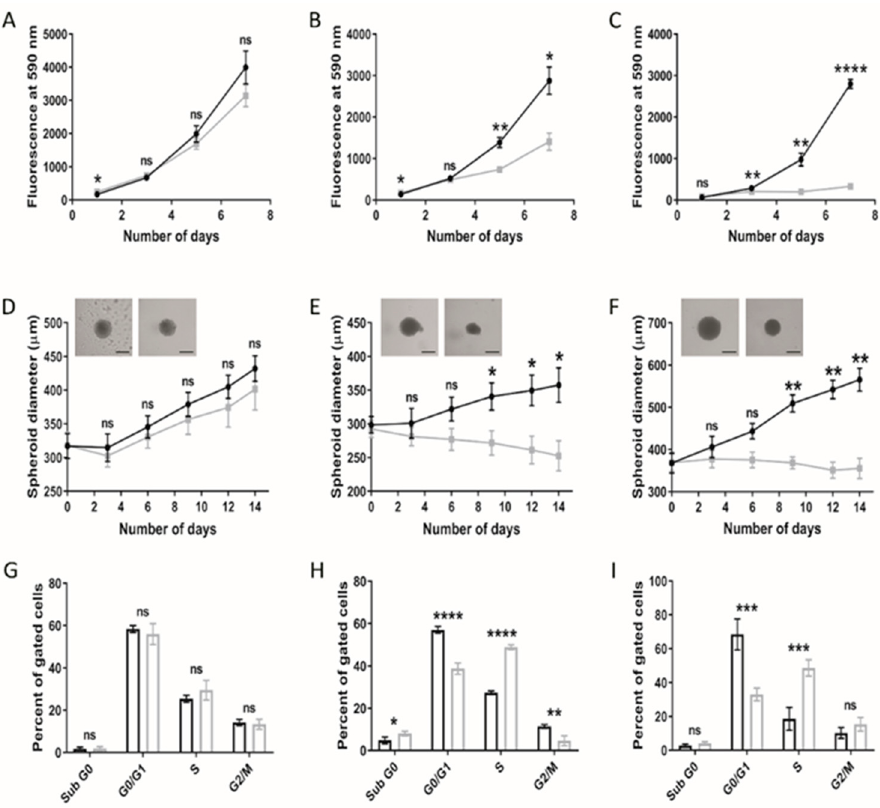
Figure 1. Altered growth characteristics of adult and paediatric diffuse glioma cells under lipoprotein-deplete conditions. U373 (adult GBM), KNS42 and SF188 (both paediatric diffuse glioma) cells were grown under lipoprotein -replete (black) or -deplete (grey) conditions in monolayer ( A – C ) or spheroid ( D – F ) format, respectively, over a 7- or 14-day period, respectively. ( D – F ) Brightfield images are representative of 14-day old spheroids in lipoprotein-replete (left) or -deplete (right) conditions. Black bars depict 300 µm in scaled length. ( G – I ) Flow cytometric cell cycle analysis following U373, KNS42 and SF188 monolayer culture, respectively, under lipoprotein -replete (black) or -deplete (grey) conditions for 72 h. Results are the mean ± SEM ( A – F ) or SD ( G – I ) for n ≥ 3 independent replicates (n = 6 spheroid replicates). Statistical evaluation of differences between lipoprotein -replete or -deplete conditions was conducted using t -tests: ns = not significant * p < 0.05; ** p < 0.01; *** p < 0.001; **** p < 0.00001.